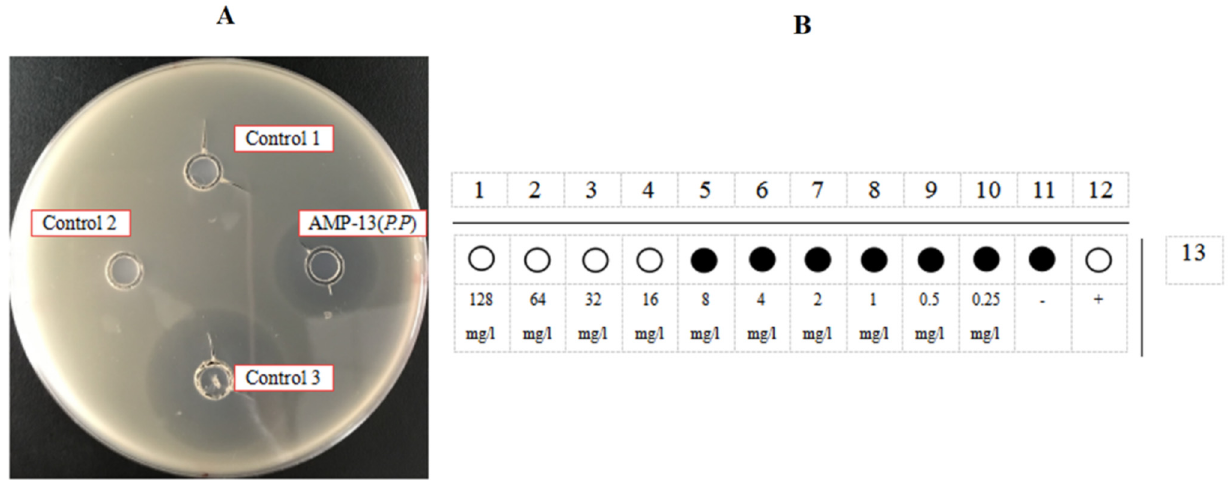
Figure 13. The activity test of AMP13 produced by P. pastoris . ( A ). Inhibition zone tests of AMP13. Control 1, HRV 3C Cleavage Buffer; Control 2, HRV 3C Cleavage Buffer with 1 M NaCl; Control 3, Positive control, ampicillin antibiotic at a concentration of 200 mg/L. Every oxford cup contains 100 µ L liquid. ( B ). The schematic diagram of a 96-well plate measuring MIC (data taken from three parallel experiments). Horizontal direction is AMP 13 test rows; Vertical direction 1–10 is the final concentration of 128 mg/L to 0.25 mg/L of these AMPs, respectively; 11 is the negative control; 12 is a positive control, the 20 mg/L ampicillin .